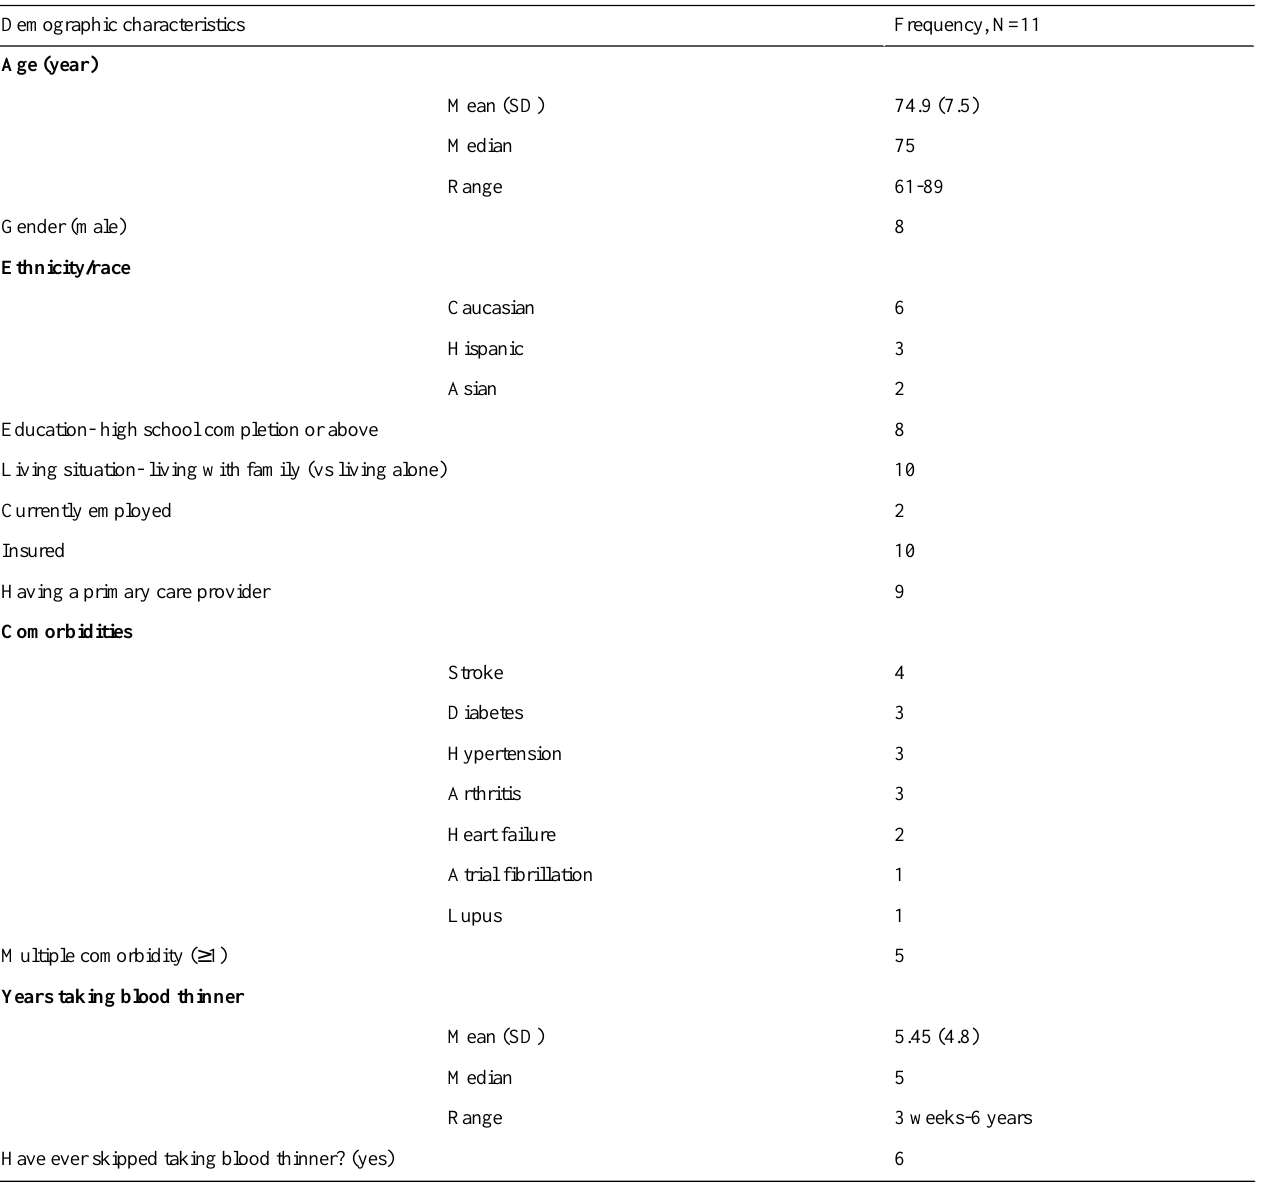
Table 2. Participants’demographic